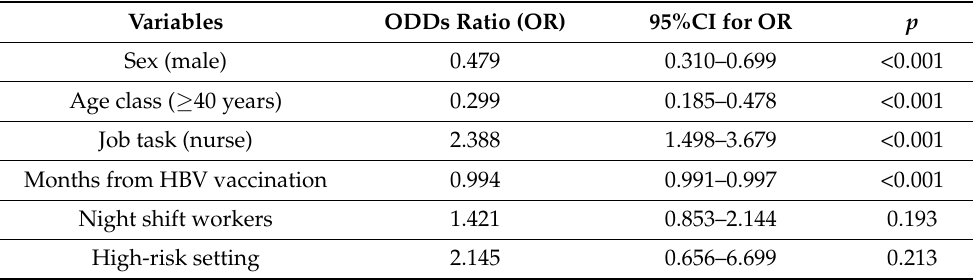
Table 3. Multivariate logistic regression model with HBs IgG levels ≥ 10 mIU/mL as a dependent